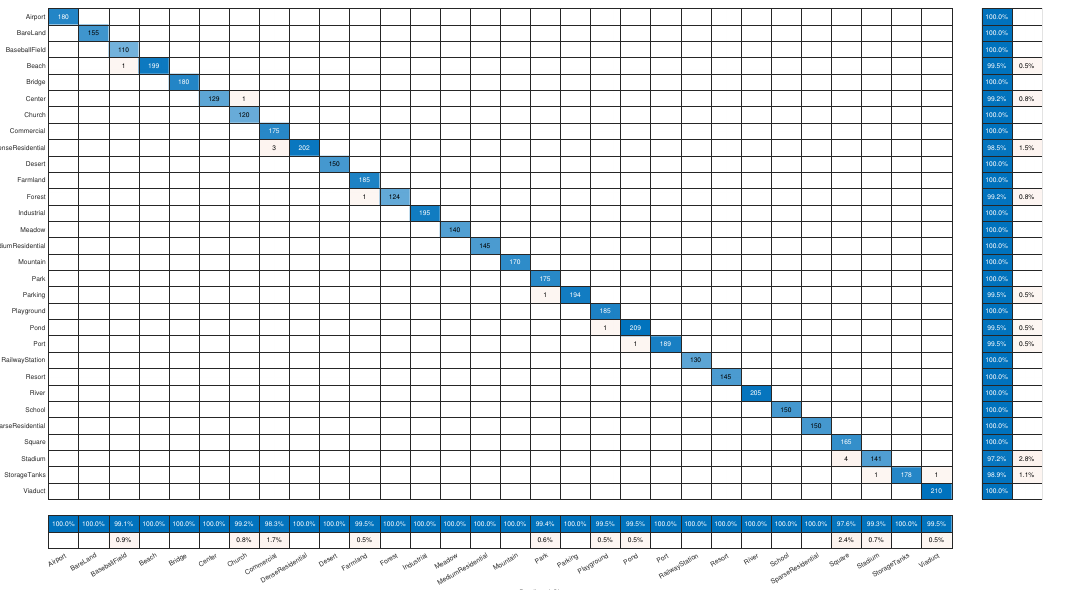
Figure 12 represents the confusion matrix generated by PBDL with the 50% training ratio. As can be seen from Figure 13, the classification performance of all the categories is higher than 95%. Specifically, 4 of images from the square are mistakenly classified as stadium, and 3 of images from commercial are misclassified as dense residential. The five categories consisting of school, square, park, center, and resort are very confusing categories, which prevented many existing works from getting a competitive performance [75]. For instance, SFCNN [69] and the CNN + GCN [23] attained 70% to 91% accuracy for the class of resort while our method achieves 100% accuracy. This confirms that despite the high interclass similarity, the proposed method is capable of extracting robust spatial location information to distinguish these remote sensing scene categories.